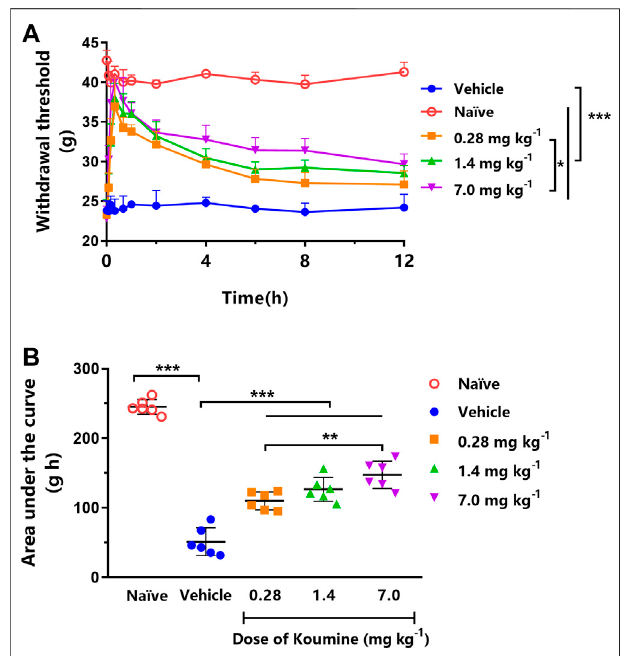
signi fi cant loss of body weight from 7 to 22 days ( p < 0.001, Figure 1C ). However, vehicle-treated rats maintained their baseline blood glucose level and MWT along with approximate 100 g body weight gain during the 22 days ( Figures 1A – C ). KM Exhibited a Dose-Dependent Anti-Allodynic Effect After a Single Oral Dose in STZ-Induced DNP Rats Each dose of orally administered KM (0.28, 1.4, and 7.0 mg kg − 1 ) signi fi cantly increased the MWT compared with the vehicle treatment in STZ-induced DNP rats (all p < 0.001, Figure 2A ). Furthermore, the effect of 7.0 mg kg − 1 KM was signi fi cantly stronger than that of KM at 0.28 mg kg − 1 ( p < 0.05, Figure 2A ). The AUCs for MWT after the oral administration of KM (0.28, 1.4, and 7.0 mg kg − 1 ) were signi fi cantly higher than after vehicle treatment in STZ- induced DNP rats (all p < 0.001, Figure 2B ). The AUC for MWT after 7.0 mg kg − 1 KM administration was 1.34- and 2.88- fold higher than that after 0.28 mg kg − 1 KM and vehicle administration, respectively (147.4 ± 8.0 vs. 109.8 ± 5.3 and 51.2 ± 8.1, respectively).